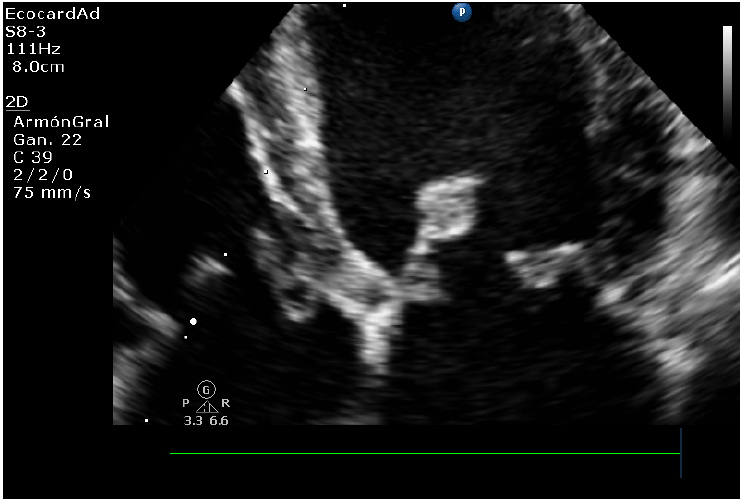
Figure 4. Myxomatous mitral valve degeneration in the canine patient’s left apical 4-chamber